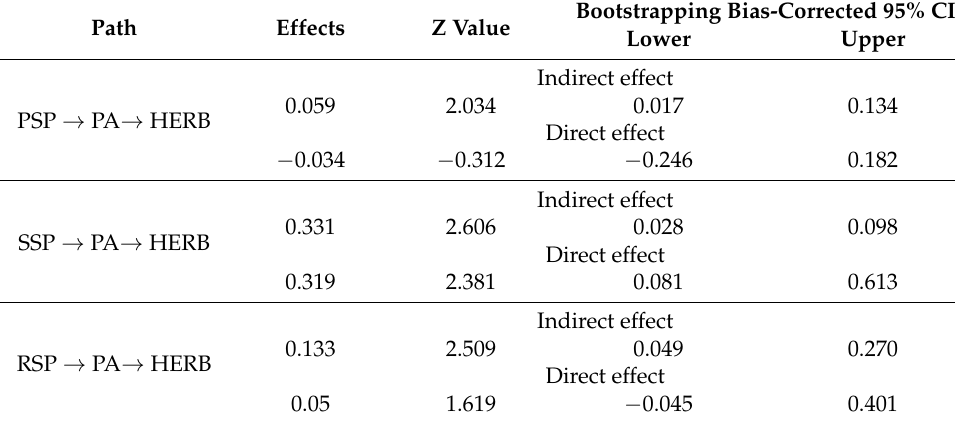
Table 7. Results of the mediation